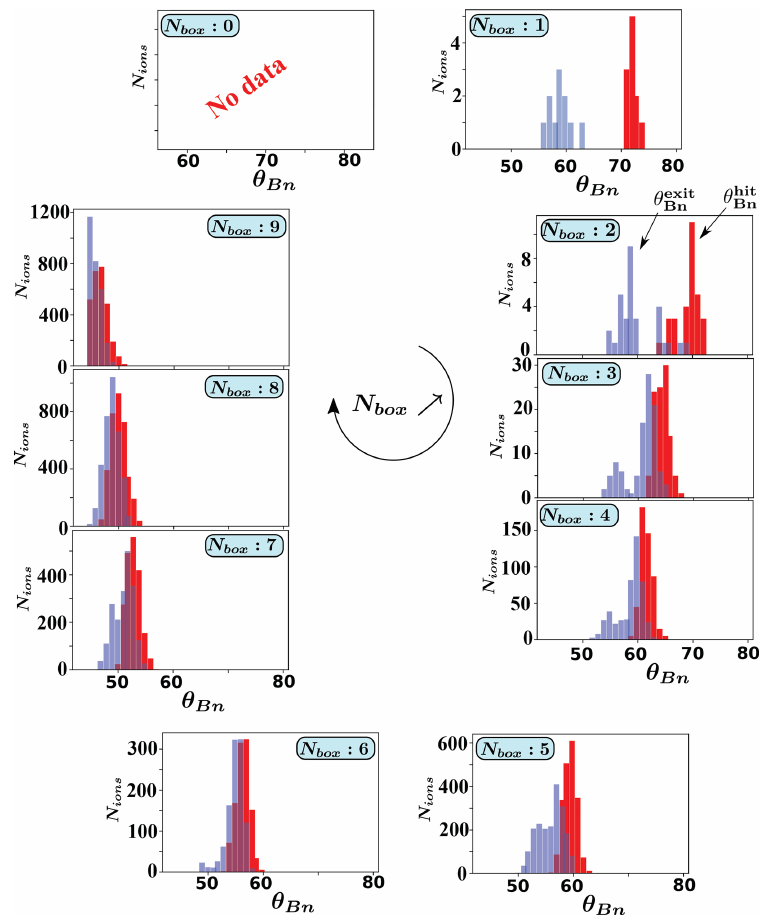
Figure 7. FCE configuration: same plots as for Fig. 4 but when electrostatic field components E l x and E l y are artificially excluded ( E l = 0). The angles θ hit and θ exit have been reported in N Box = 2 for reference Bn Bn